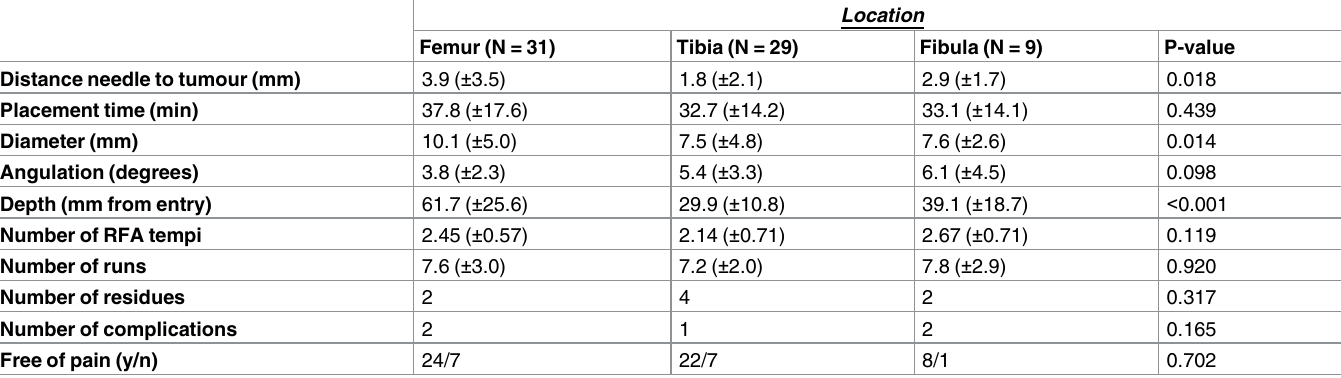
Table 3. Population separated in groups on location.